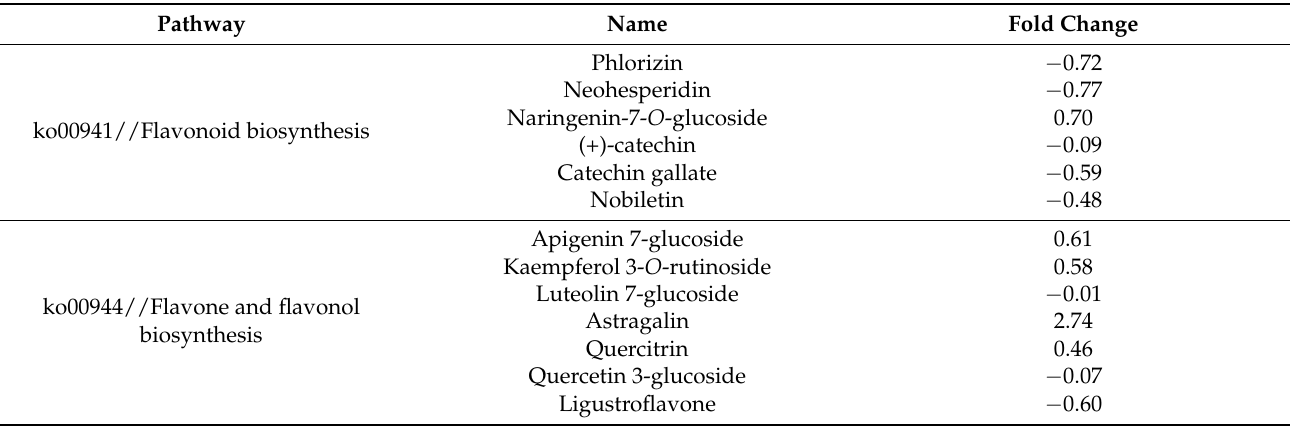
Table 3. Main differentially expressed metabolites related to flavonoid biosynthesis in WT and RuFLS2-OX